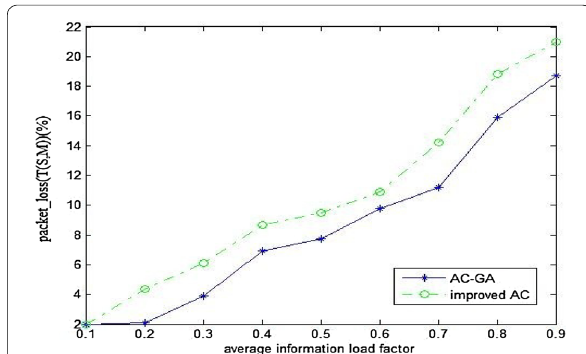
Figure 10 Comparison of packet_loss( T ( S , M )) of improved AC and AC‑GA